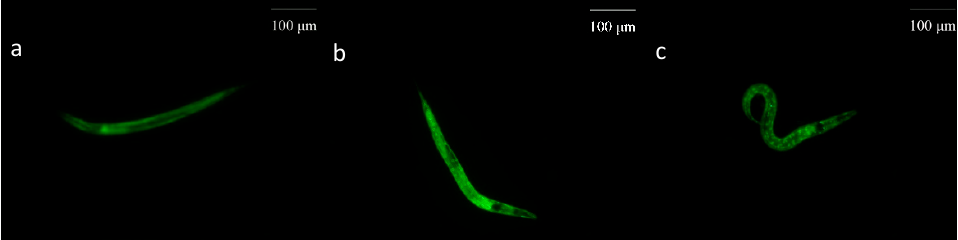
Figure 10. The transcriptional activity of daf-16 . ( a ) The cytosolic localization of DAF-16::GFP. ( b ) Both cytosolic and nuclear localization of DAF-16::GFP. ( c ) The nuclear localization of DAF-16::GFP.